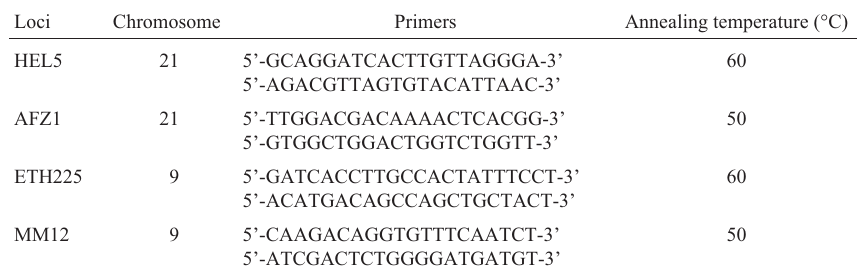
Table 1 - Investigated loci with their chromosome location, primer sequences and annealing